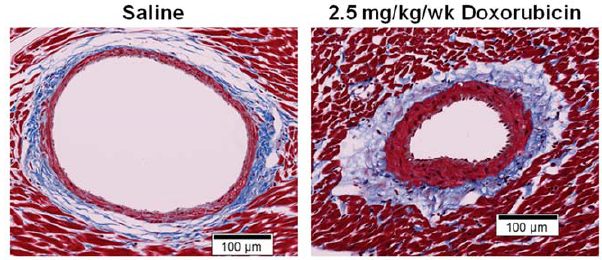
Figure 2. Coronary arteriolar histology in saline versus Doxorubicin sample. Coronary arteriolar histology from an animal treated with normal saline (1cc/week) for 7–10 weeks (left) with a coronary arteriole obtained from an animal treated with 2.5 mg/kg/ week of doxorubicin for 10 weeks (right). Compared with the normal saline treated artery, the doxorubicin treated artery has increased medial and adventitial thickness.